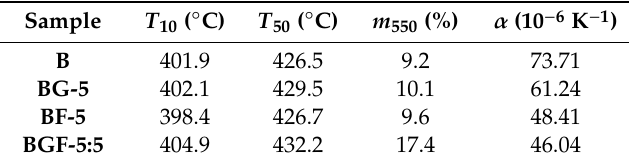
Table 14. Results of thermogravimetric analysis of the prepared composite materials based on recycled PETG.